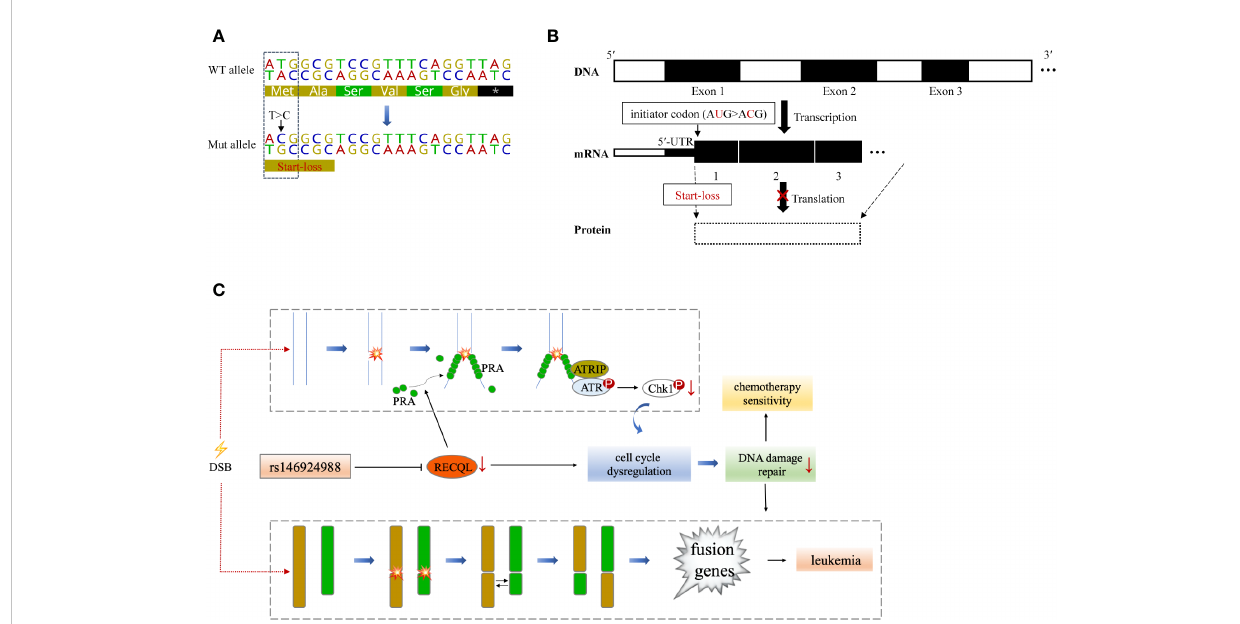
FIGURE 3 A theoretical model that RECQL mutation (rs146924988) acts as a potential mediator of hereditary leukemia. (A) Variant details of single nucleotide variation in RECQL (rs146924988). Dotted box indicates the corresponding DNA sequence of the initiator codon. (B) Hypothetical mechanism that RECQL mutation (rs146924988) affecting transcription and translation. The rs146924988 mutation is an initiator codon variant of RECQL , which may lead to a start-lost loss-of-function of RECQL. (C) A theoretical model that rs146924988 acts as a mediator of hereditary leukemia. The germline mutation (rs146924988) was proposed to mediate the occurrence of chromosome rearrangement and fusion genes, as well as affect chemotherapy sensitivity. WT, wide type; Mut, mutant; DSB, DNA double-strand